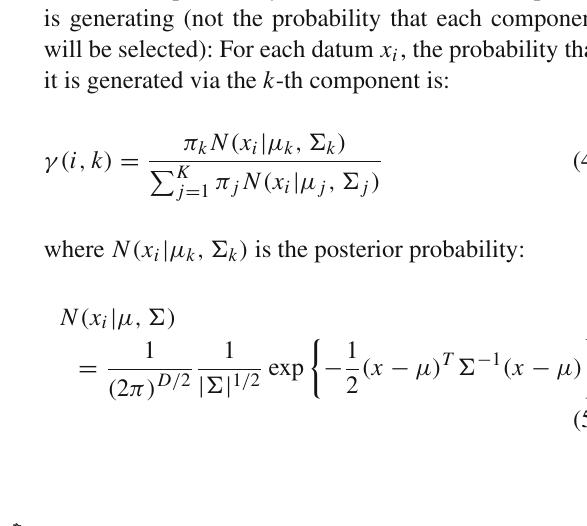
estimation method for solving the parameters of a proba- bility model from incomplete data or data sets with missing data (the presence of hidden variables). The E step uses the existing estimates of the hidden variables to calculate their maximum likelihood estimates; meanwhile, the M step max- imizes the maximum likelihood values found in the E step to calculate the values of the parameters, and it iterates until